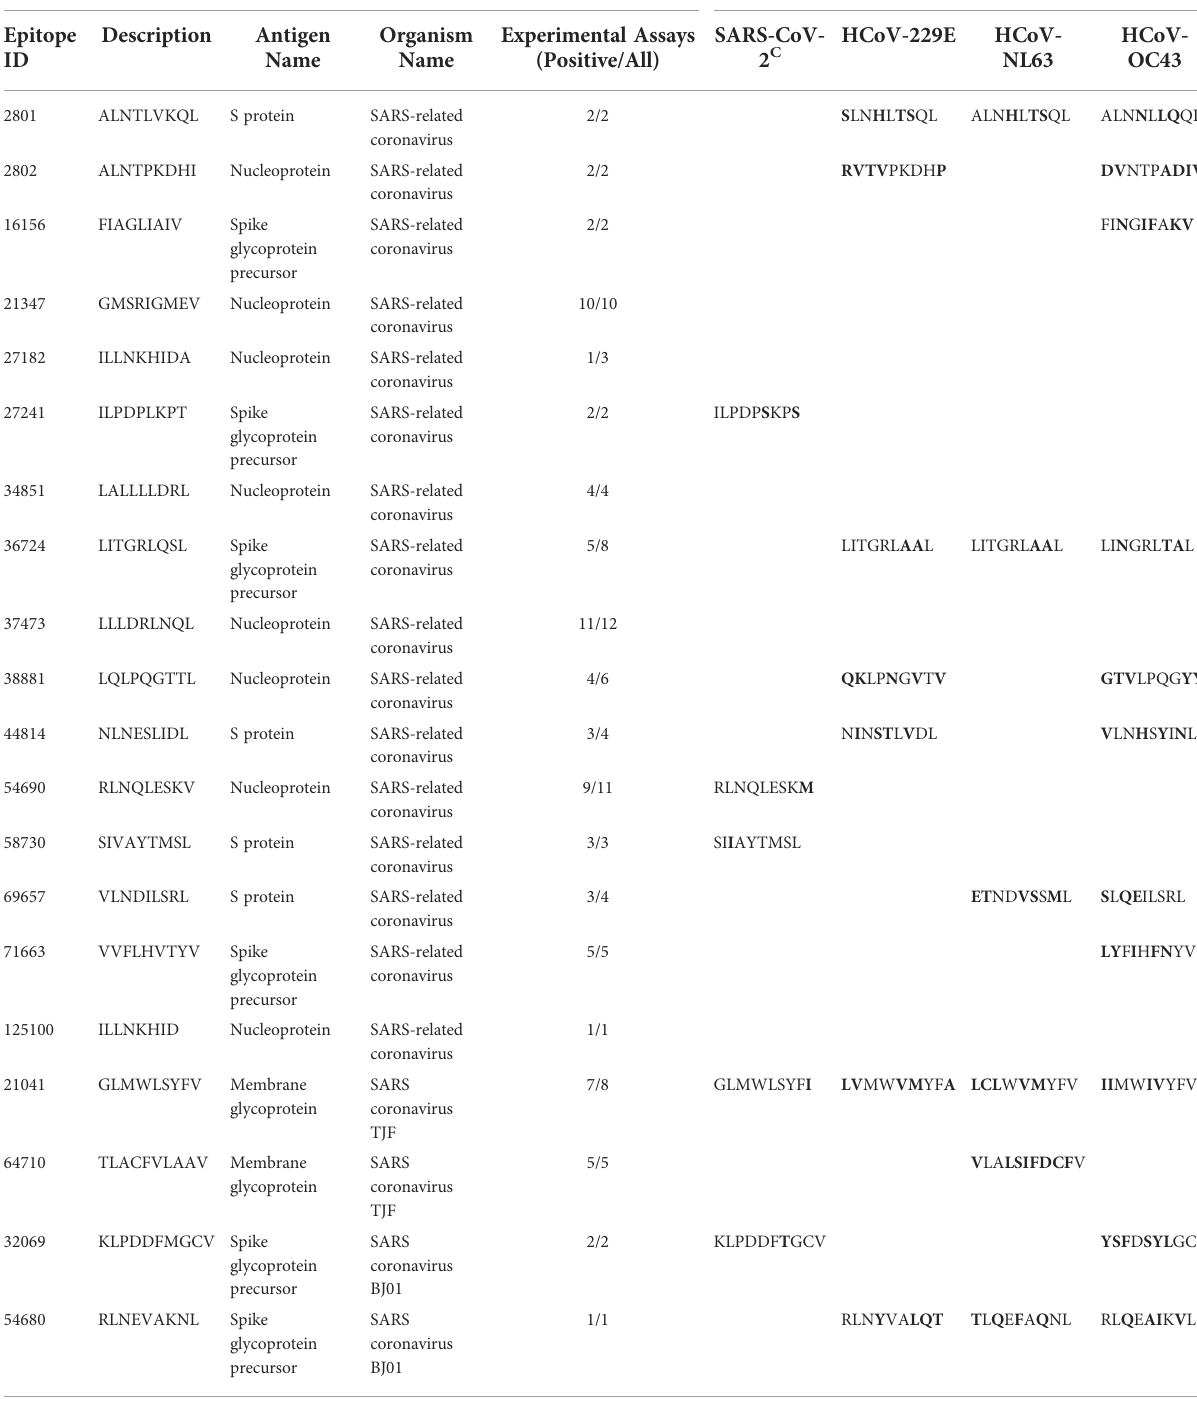
TABLE 1 Recovered HLA-A*02:01 epitopes from SARS-CoV SARS-Cov-2 and other alpha and beta coronaviruses members. IEDB - experimental positive epitopes from coronaviruses